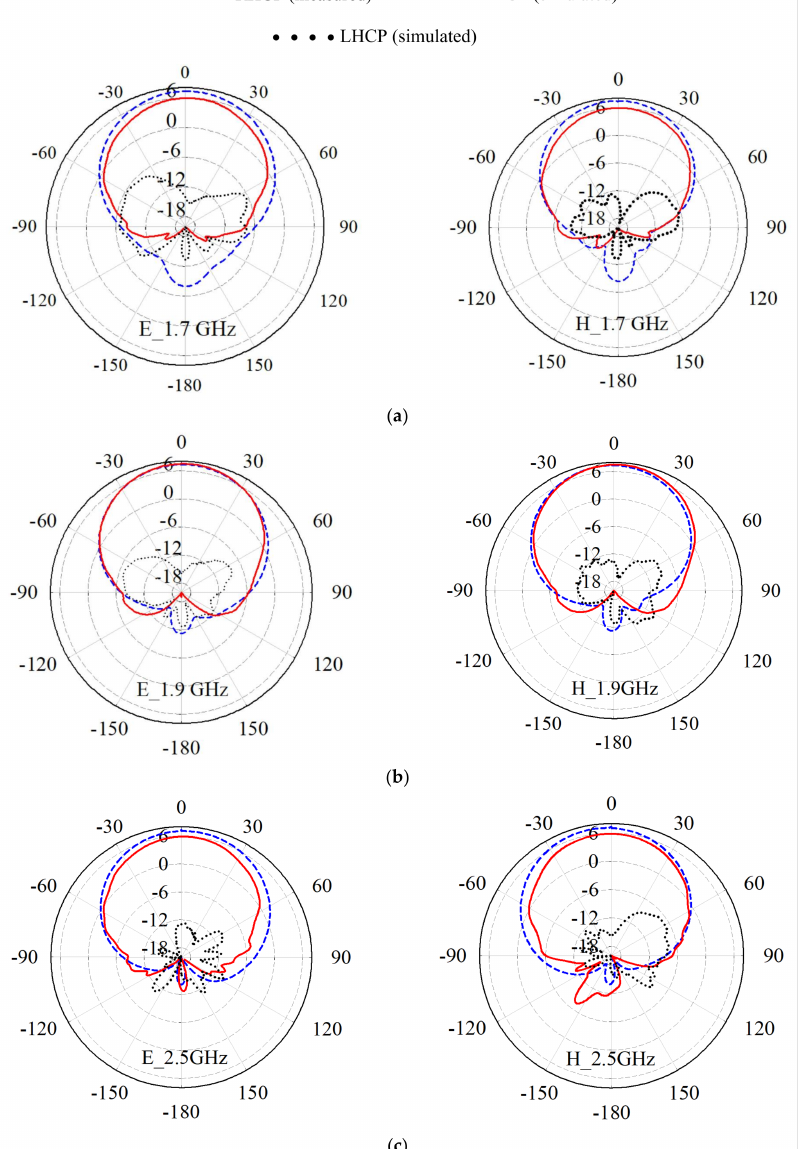
Figure 11. Simulated and measured E- and H-field radiation patterns of the proposed PCD antenna at ( a ) 1.7 GHz; ( b ) 1.9 GHz; ( c ) 2.5